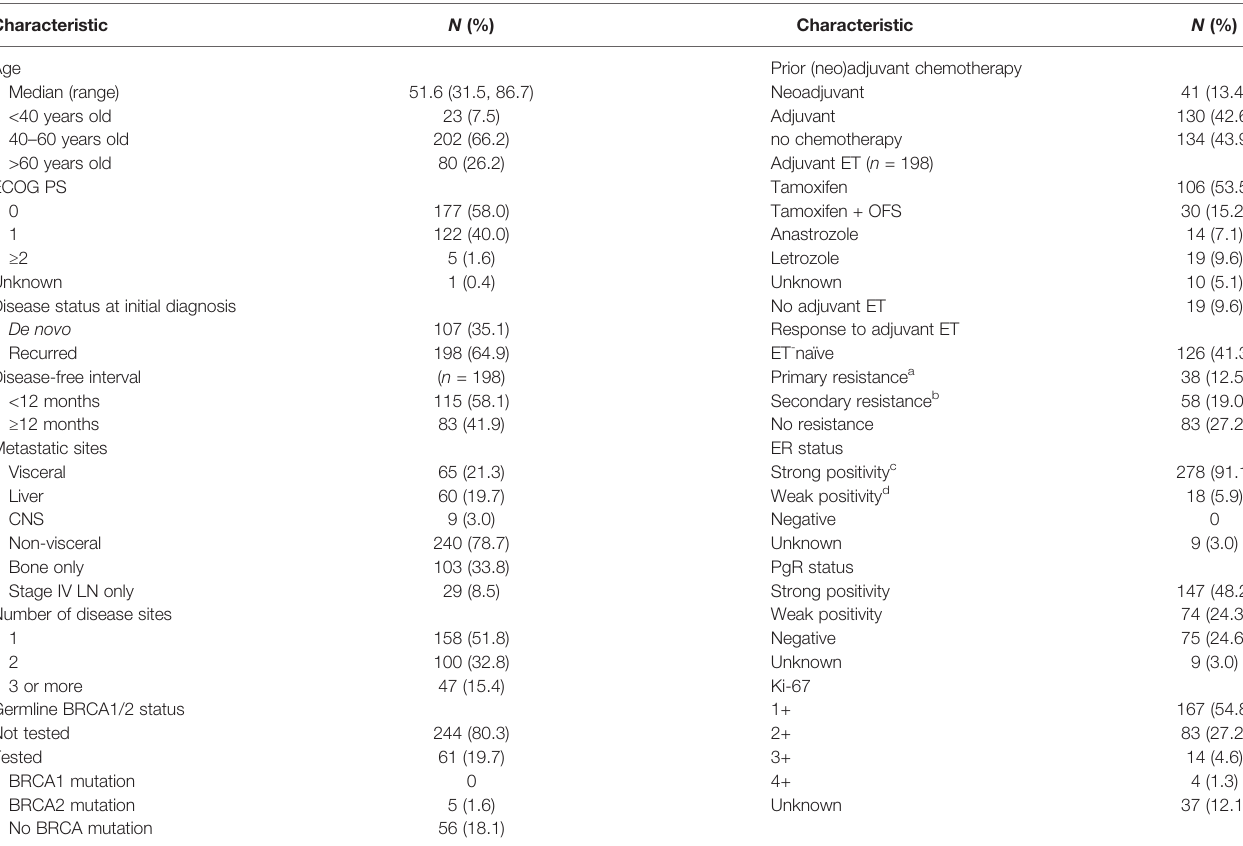
TABLE 1 | Baseline patient characteristics ( N =